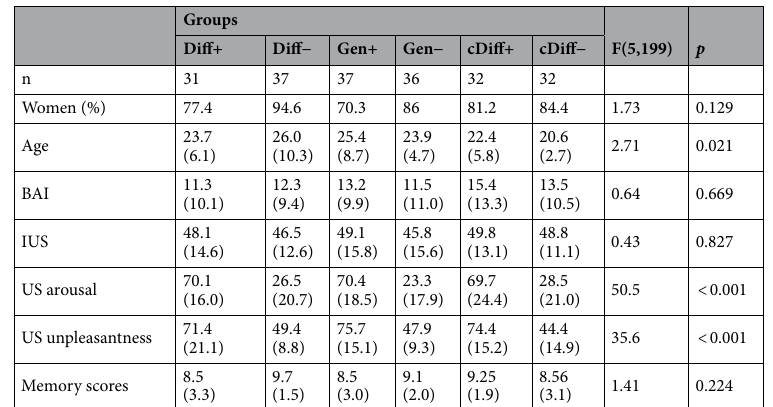
Table 1. Summary of group characteristics. Diff = differential learning group, Gen = generalization learning group, c = control discrimination task (CS −), + = aversive US, − = neutral US, BAI = Becks Anxiety Inventory, IUS = Intolerance of Uncertainty Scale. Numbers indicate means (± S.D.).